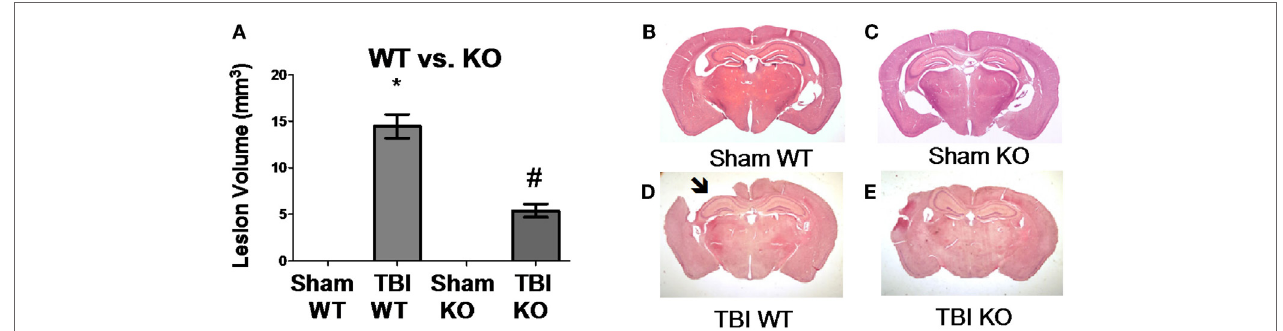
but the TBI KO mice had roughly one-third the loss suffered by the TBI WT mice. Representative micrographs from the brains of Sham WT, Sham KO, TBI WT, and TBI KO animals are shown in (B–e) , respectively. (mean ± SEM, Bonferroni’s multiple comparison test P < 0.05, N = 10 animals/group, *TBI